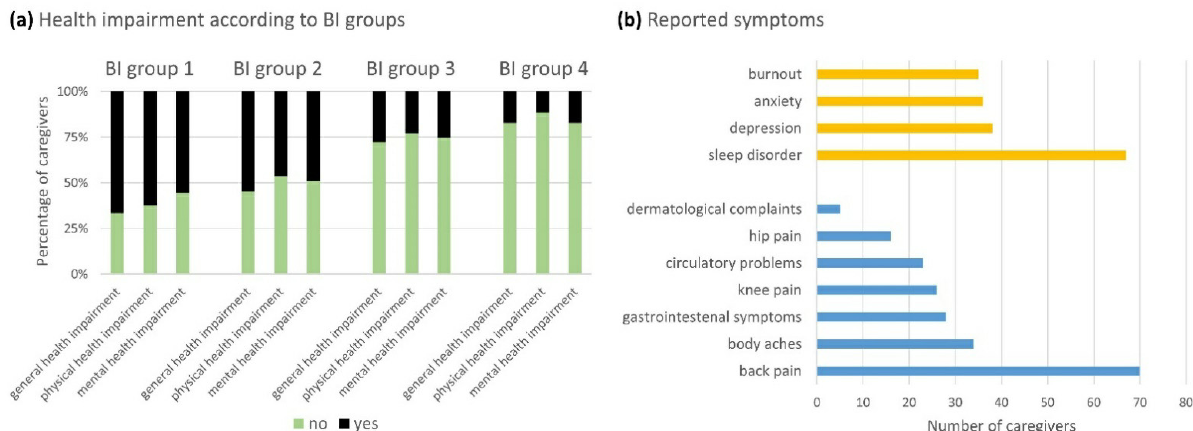
Figure 4. Caregivers’ health impairment: The caregivers were able to state if they felt health-impaired themselves due to caregiving (yes) or not (no) ( a ) and could differ between physical (blue) and mental (yellow) symptoms ( b ). Three adjacent columns in ( a ) are assigned to each BI group (groups 1–4). The extent of the colored sections represents the percentage of caregivers. We observed a statistically significant increase in the incidence of physical and mental health impairment according to the BI group (BI group 4 (=BI score 100 points = full independence) to BI group 1 (= BI score 0–20 points = full dependence)) and thus decreasing autonomy of the patients. Abbreviations: BI = Barthel Index.